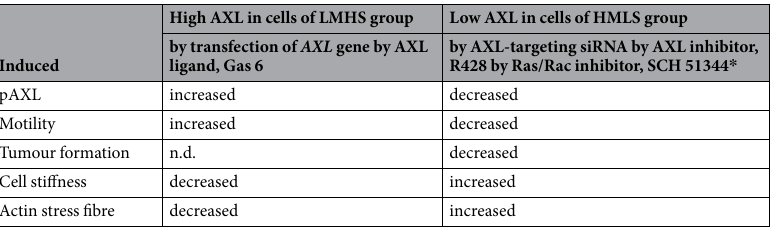
Table 2. Cellular effects of activation or inhibition of AXL activity in lung cancer cell lines. HMLS: high motility-less stiffness; LMHS, low motility-high stiffness. n.d.: not determined. * Induced similar phenotypes to low